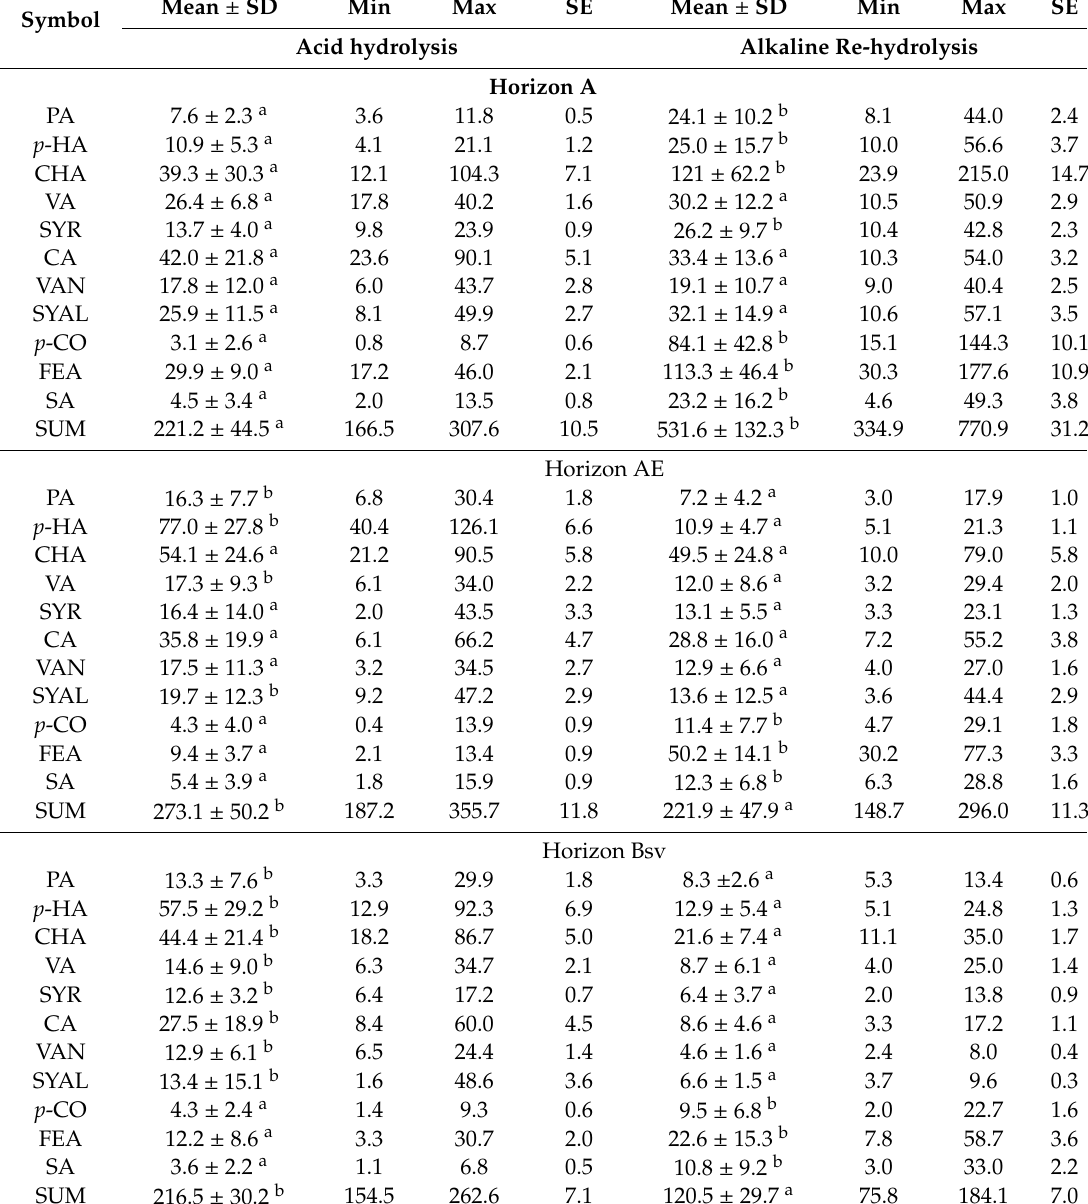
Table 2. Content of phenolic compounds in plant material and soil ( µ g / g